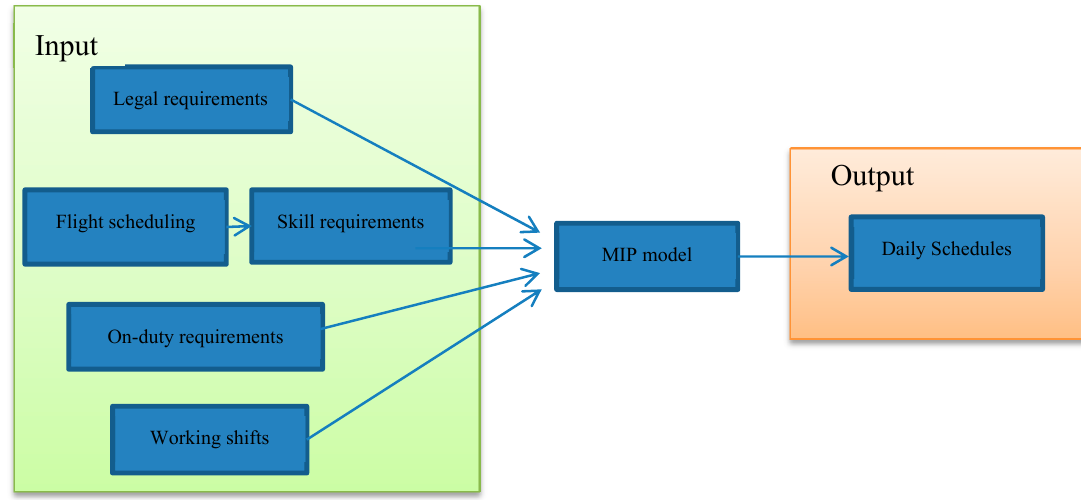
Figure 2. Framework of the mixed integer programming model.